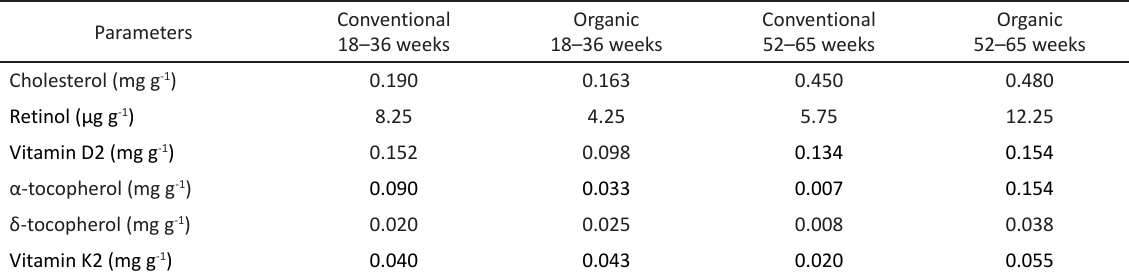
Table 3. Levels of cholesterol and vitamins A (retinol), D (D2), E (α- and δ- tocopherols), and K (K2) in the feeds Parameters